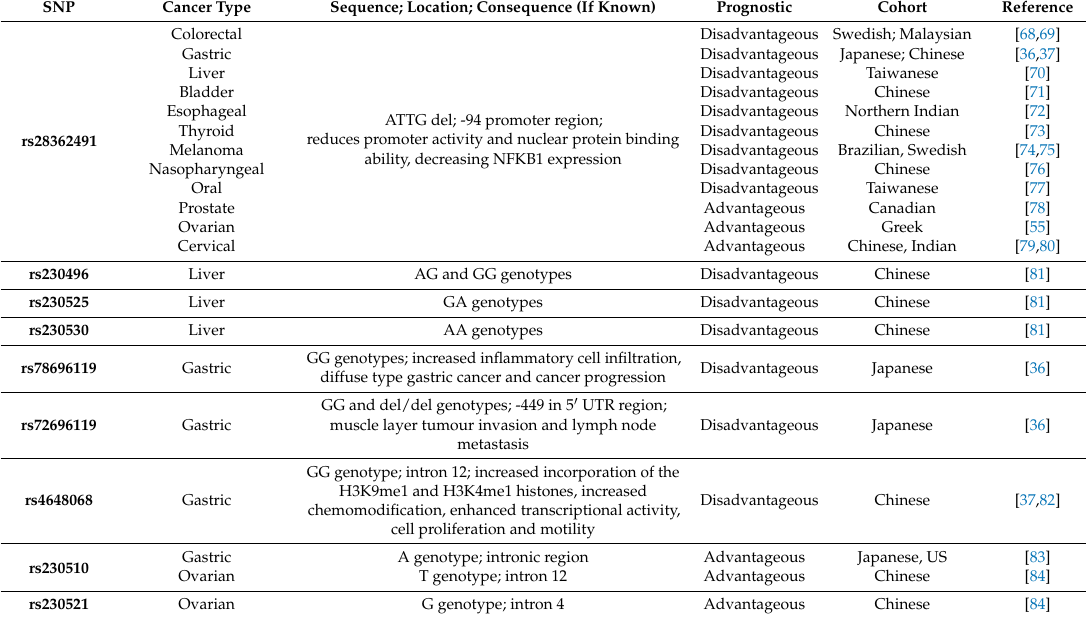
Table 1. NFKB1 SNPs (Single Nucleotide Polymorphisms) associated with cancer. NFKB1 polymorphisms in different c-94ancer types are associated with either an advantageous or disadvantageous prognosis in different population